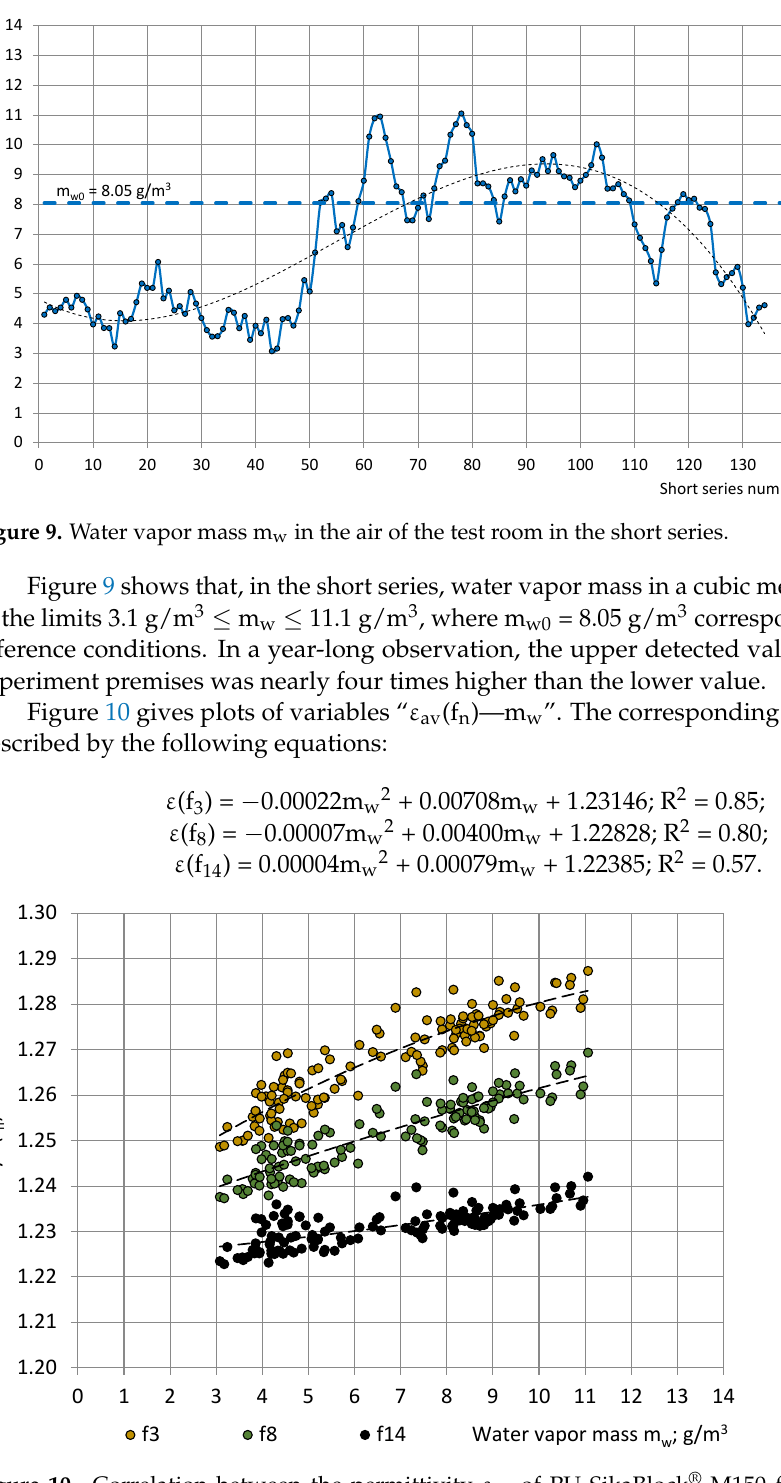
Figure 10. Correlation between the permittivity ε av of PU SikaBlock ® -M150 foams (density of 144 kg/m 3 ) and the water vapor mass m w in the air of the test room at frequencies f 3 = 40 Hz (beige), f 8 = 1280 Hz (green), and f 14 = 81,920 Hz (black).